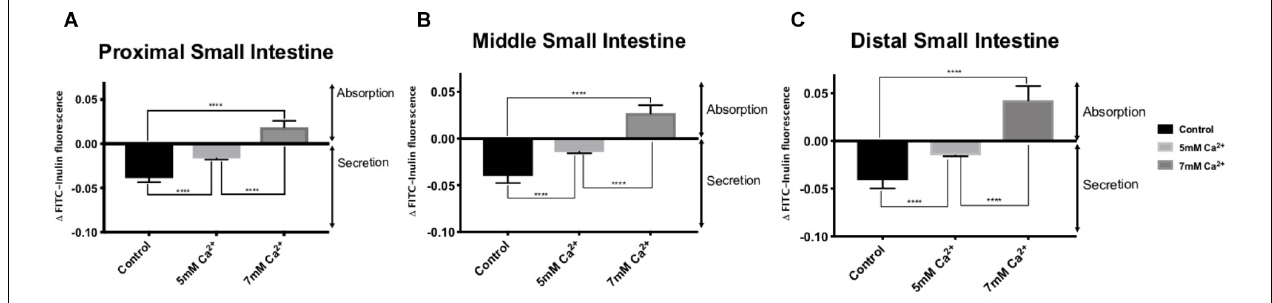
FIGURE 1 | Effect of increasing intraluminal [Ca 2 + ] on basal intestinal fluid secretion in the: (A) Proximal small intestine (B) Middle small intestine (C) Distal small intestine. P value < 0.0001 is represented by ∗∗∗∗ .